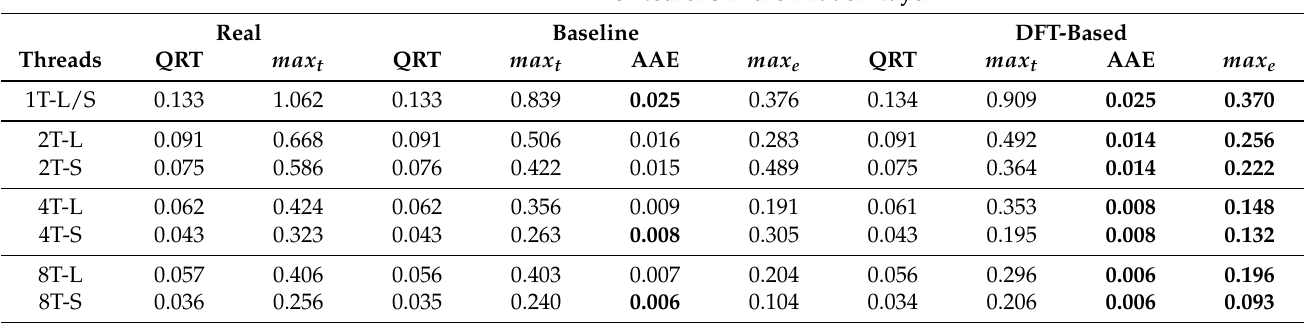
Table 9. Results obtained under ClueWeb09-BM25 with the actual execution of the multi-threaded query solution algorithms LBM-WAND (L) and SBM-WAND (S), and the respective query running time predictions delivered by the proposed and baseline